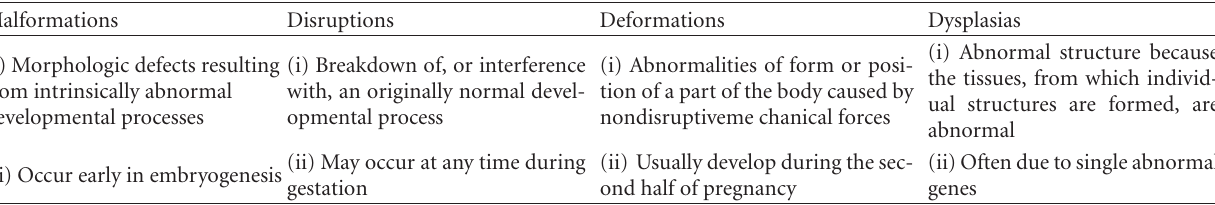
Table 1: Types of congenital anomalies.